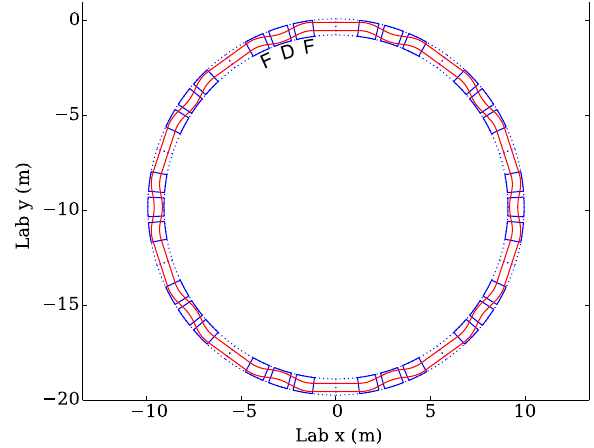
FIG. 7. A schematic of the NORMA ring lattice showing the lowest (inner) and highest (outer) energy orbits in red. Magnets are outlined by solid blue lines and the cell boundaries as dashed blue lines. The approximate positions of the F and D magnets are indicated for one cell. Note that the solid blue outlines indicate only the approximate radial positions and horizontal aperture of the magnets, however the sector width of each is accurate.